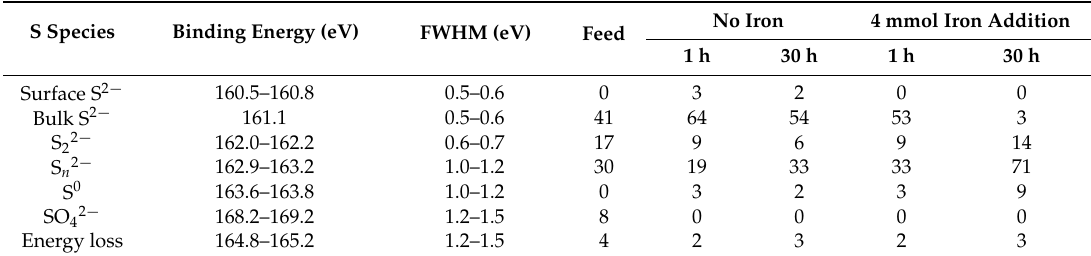
Table 4. S species (% S) for feed chalcopyrite and chalcopyrite surfaces leached at 750 mV, 75 ˝ C and pH 1.0 for 1 h and 30 h.